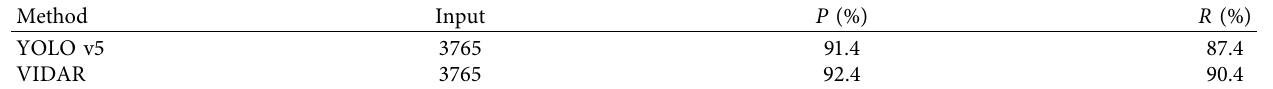
Table 2: The results in the parking space detection experiment of underground parking